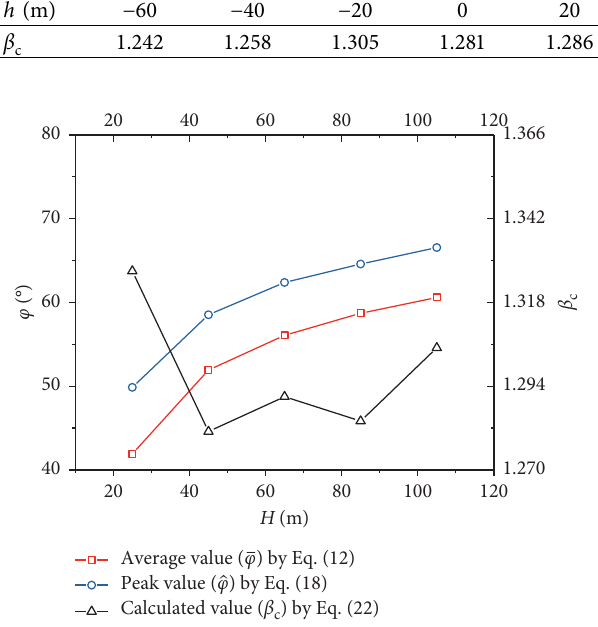
Figure 8: Influence of nominal height ( H ) on the windage yaw angle ( φ ). Table 5: Influence of nominal height on the dynamic wind load factor of the windage yaw angle.